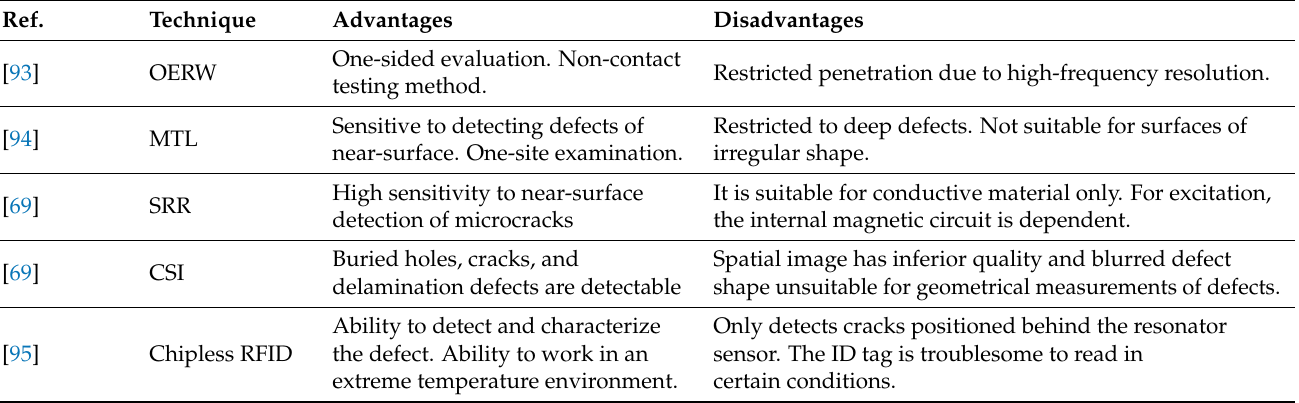
Table 2. Merits and demerits of microwave NDT